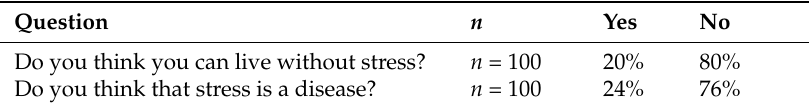
Figure 2. Has stress caused the illness you contracted to be more severe? Table 4. Answers to the question: do you think that stress is a disease/you think you can live without